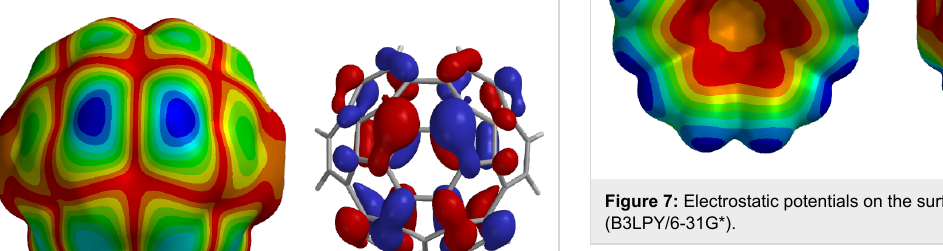
bonding orbitals in two different formats. As these images show, the LUMO of circumtrindene has its largest coefficients greatest degree of pyramidalization. This is precisely where the Bingel–Hirsch reaction and the Prato reaction of circum- trindene occur. The DFT calculations and the experimental results are therefore in complete agreement.